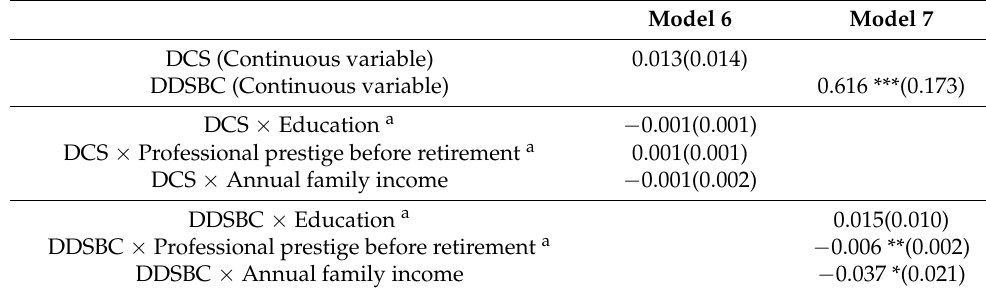
Table 5. The moderating effect of socioeconomic